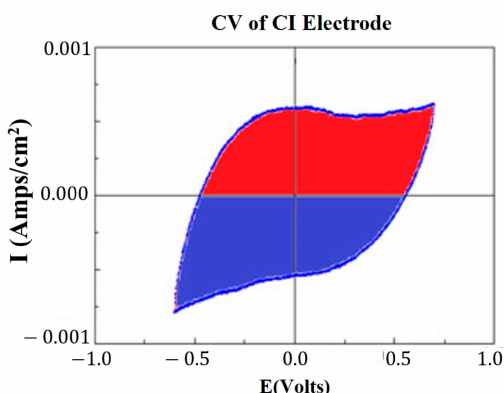
Figure 1. CV of CI electrode. Image is taken from CorrView (Scribner Associates, Southern Pines, NC, USA). The CV is graphed as I (current) vs. E (voltage). The Q value is an estimate of the average of the area of the red region and the area of the blue region.